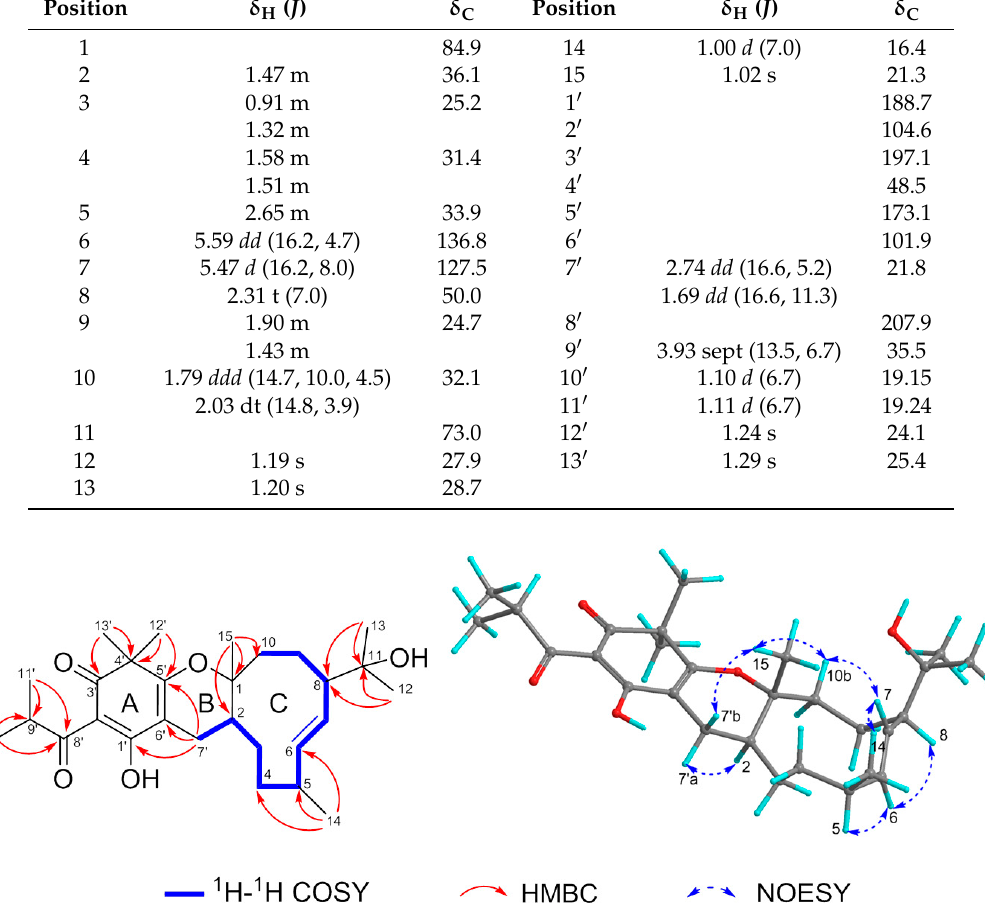
Figure 2. Key 2D NMR correlations of compound 1 .